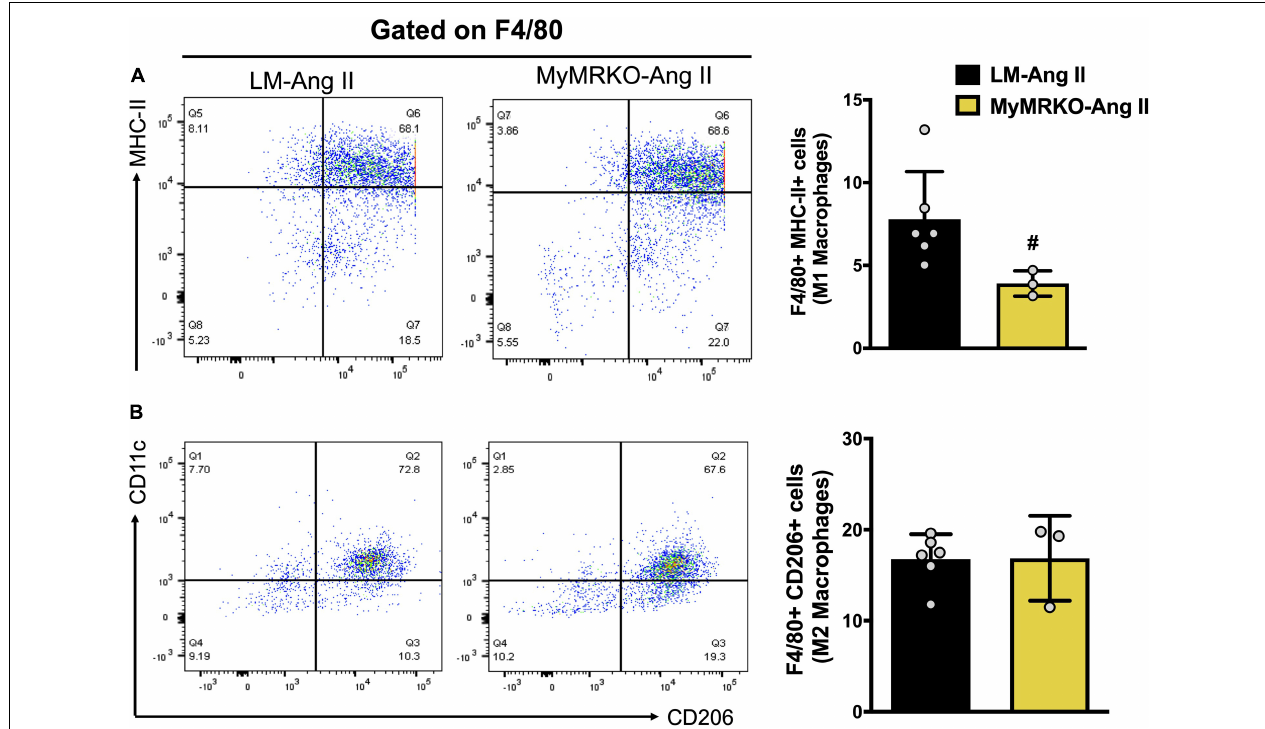
FIGURE 6 | Myeloid MR deletion reduces M1 macrophage polarization in mice infused with Ang II. Flow cytometer analysis of macrophages isolated from visceral adipose tissue. (A) M1-macrophage polarization and (B) M2-macrophage polarization; # p ≤ 0.05 LM-Ang II vs. MyMRKO-Ang II. n = 3–6. LM, littermate; Ang II, angiotensin II; MyMRKO, myeloid mineralocorticoid receptor